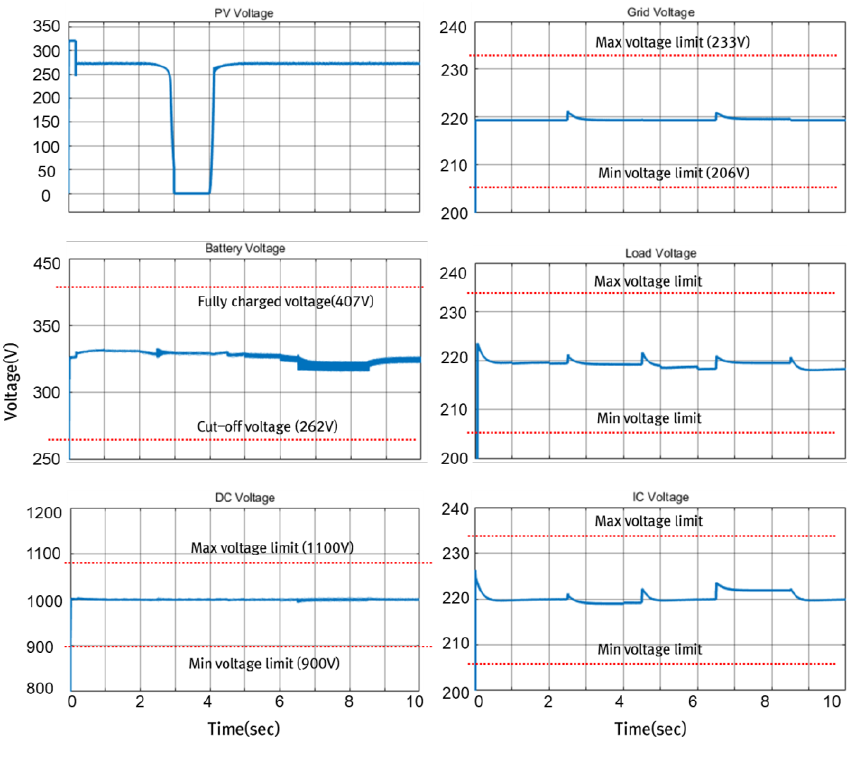
Figure 10. Comparison among voltages.